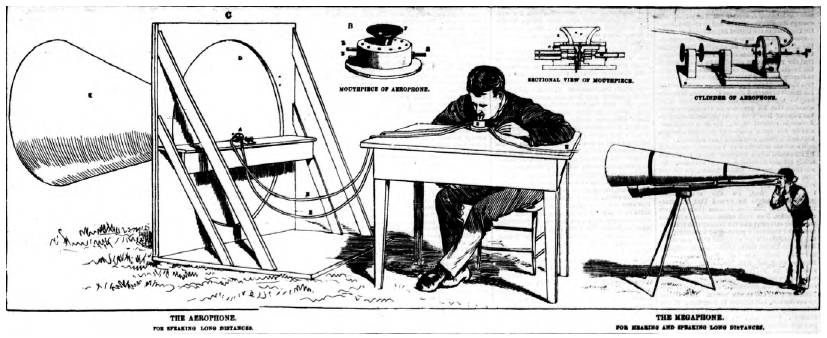
Fig. 2 “The Latest of Mr. Edison’s Inventions,” Daily Graphic , July 19,